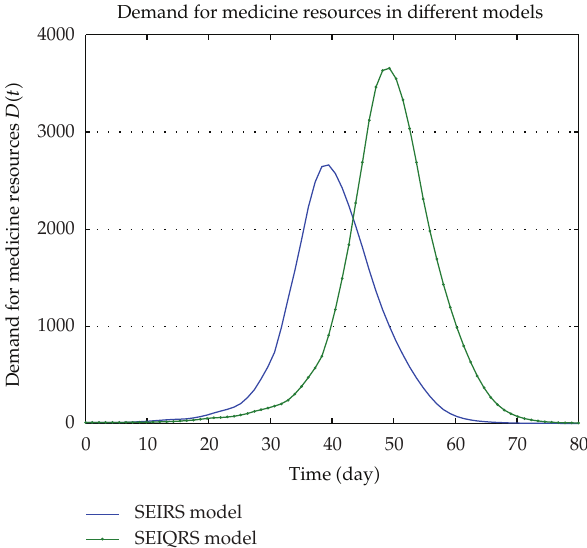
Figure 6: Demand for medicine resources in di ff erent